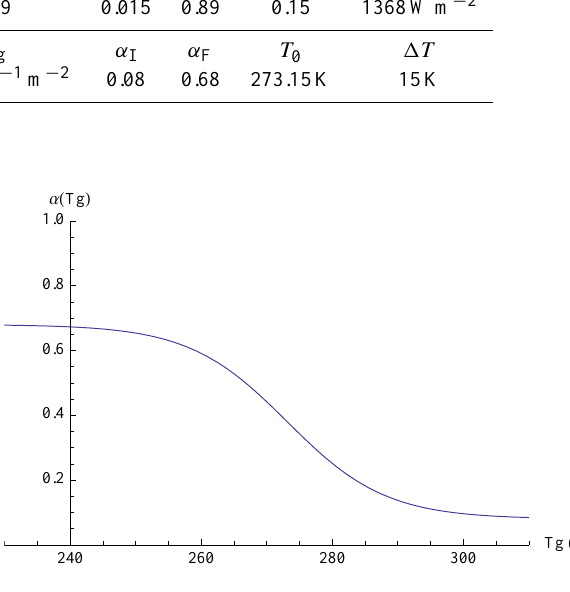
Fig. 3. Surface albedo α as a function of surface temperature T g in K.